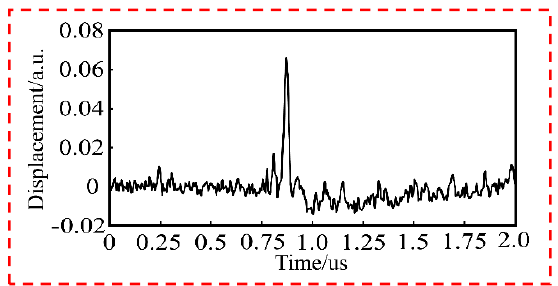
Figure 9. The detected displacement due to a photoacoustic wave.